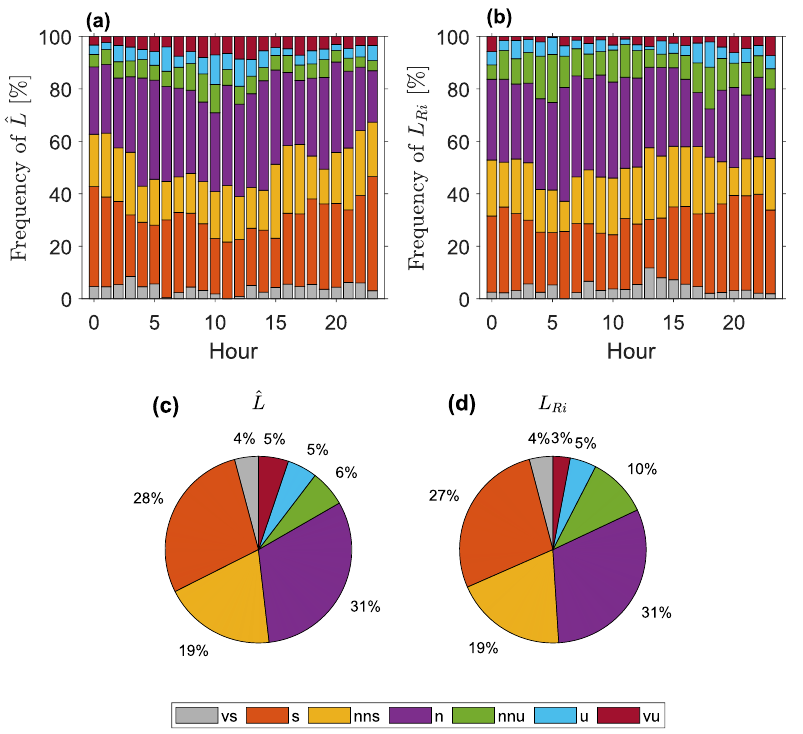
Figure 12. Overall campaign stability classification results (Gryning et al. [51] criterion) using the same format as in Figure